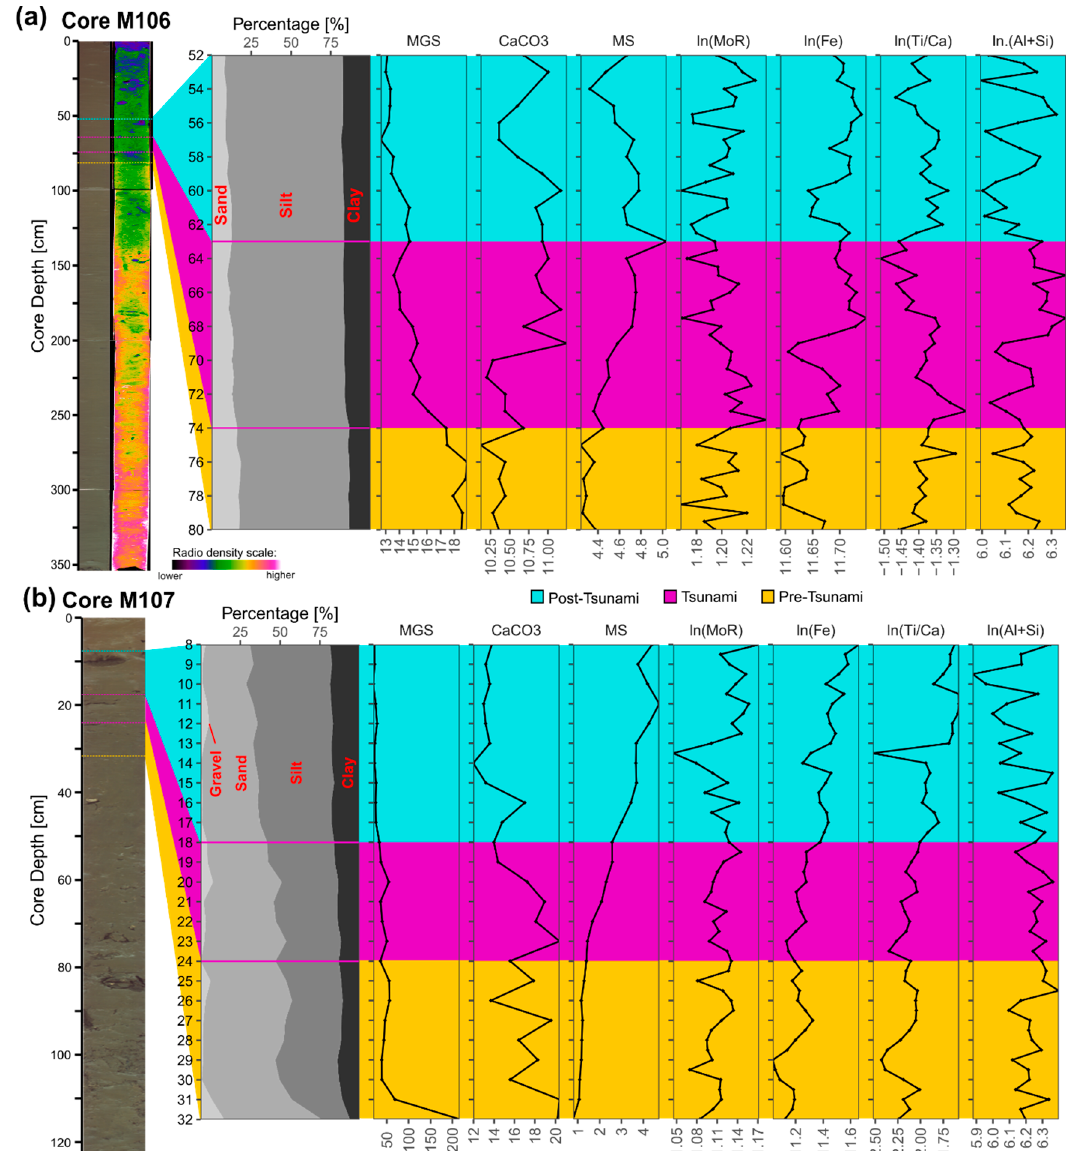
Figure 5. Multiproxy plot of core ( a ) M106 (91m bsl) and ( b ) M107 (58 m bsl) showing the studied section (Figure 2). From left to right: core image, computed tomography scan (CT-scan) (only for core M106), textural type percentages, mean grain size (MGS) ( μ m), CaCO 3 -content (%), magnetic susceptibility (MS) (10 − 7 SI), log transformed XRF elemental counts/ratios and MoR-ratio (cps). Horizontal blue, violet and yellow lines/bars represent the sections analyzed in detail for multivariate statistical analysis, SC and MT and their respective chronological group: post-tsunami (blue), 1755 CE tsunami (violet), pre-tsunami (yellow).